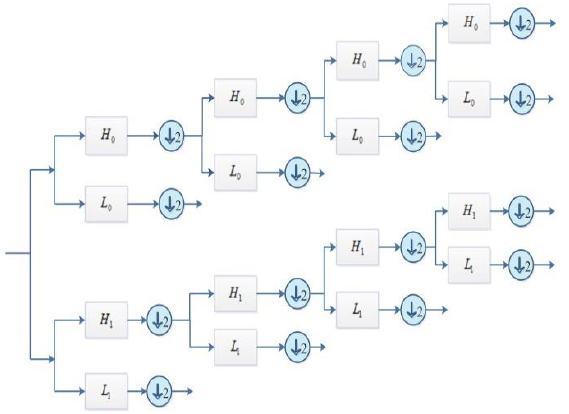
Fig. 3. Representation of the functioning of the DTCWT tree.